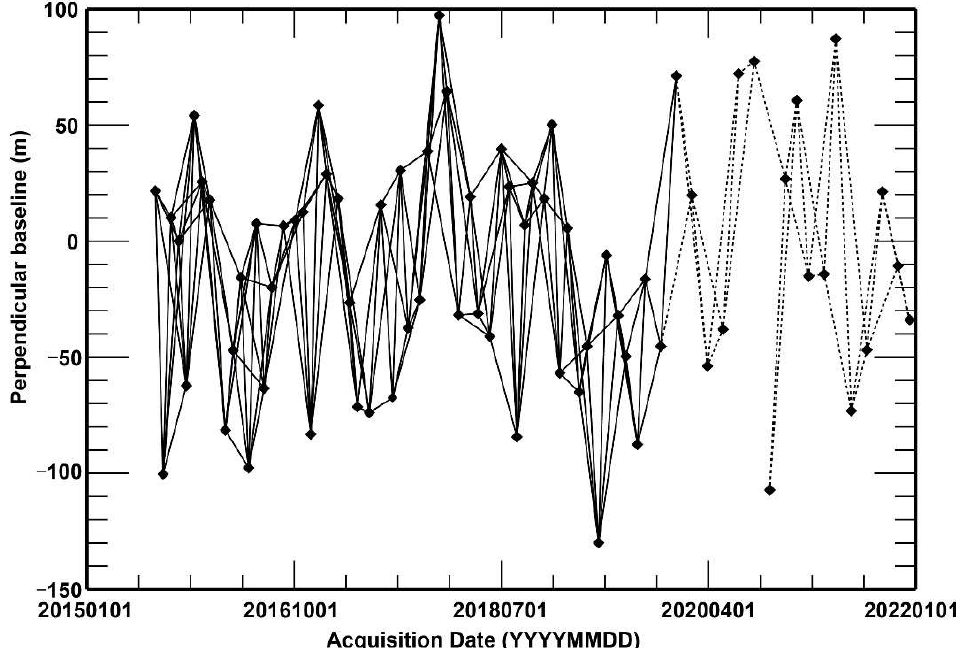
Figure 2. The spatiotemporal baseline distribution of differential interferograms used in this study. The black dots denote the acquisition dates of SAR data. The black solid lines represent the in‑ terferometric combinations of the archived SAR data in the first group for parameter initializa‑ tion. The black dashed lines represent the new generated interferometric combinations between the newly acquired SAR data and relatively new acquisition dates in the archived SAR data for the sequential